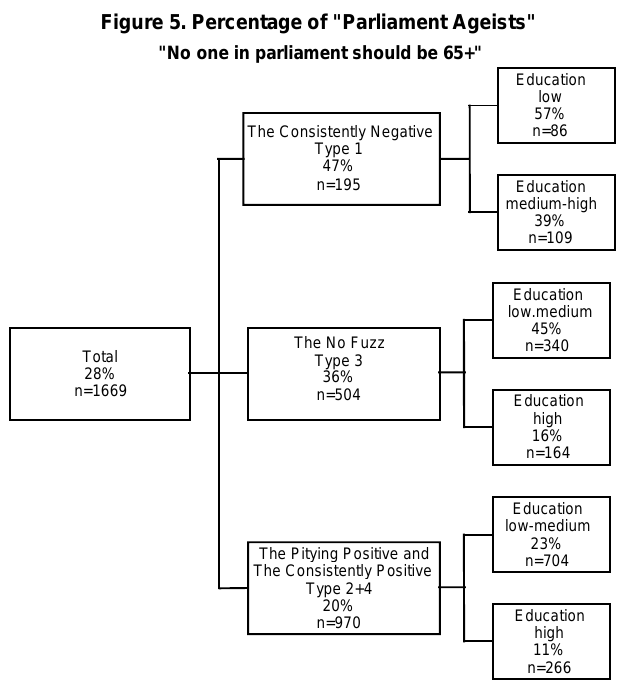
Figure 5. Percentage of "Parliament